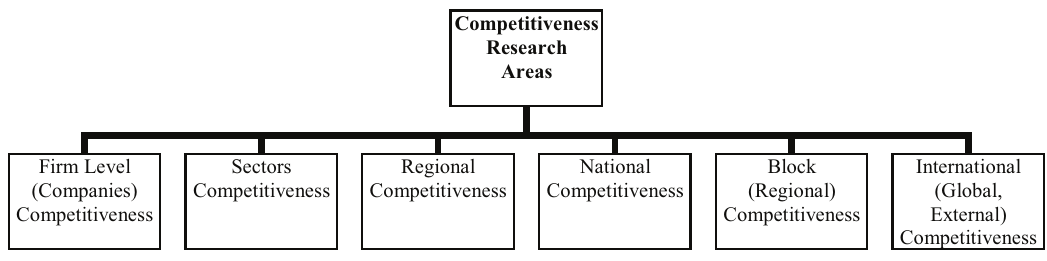
Fig. 1. Classification of competitiveness research areas. Source: